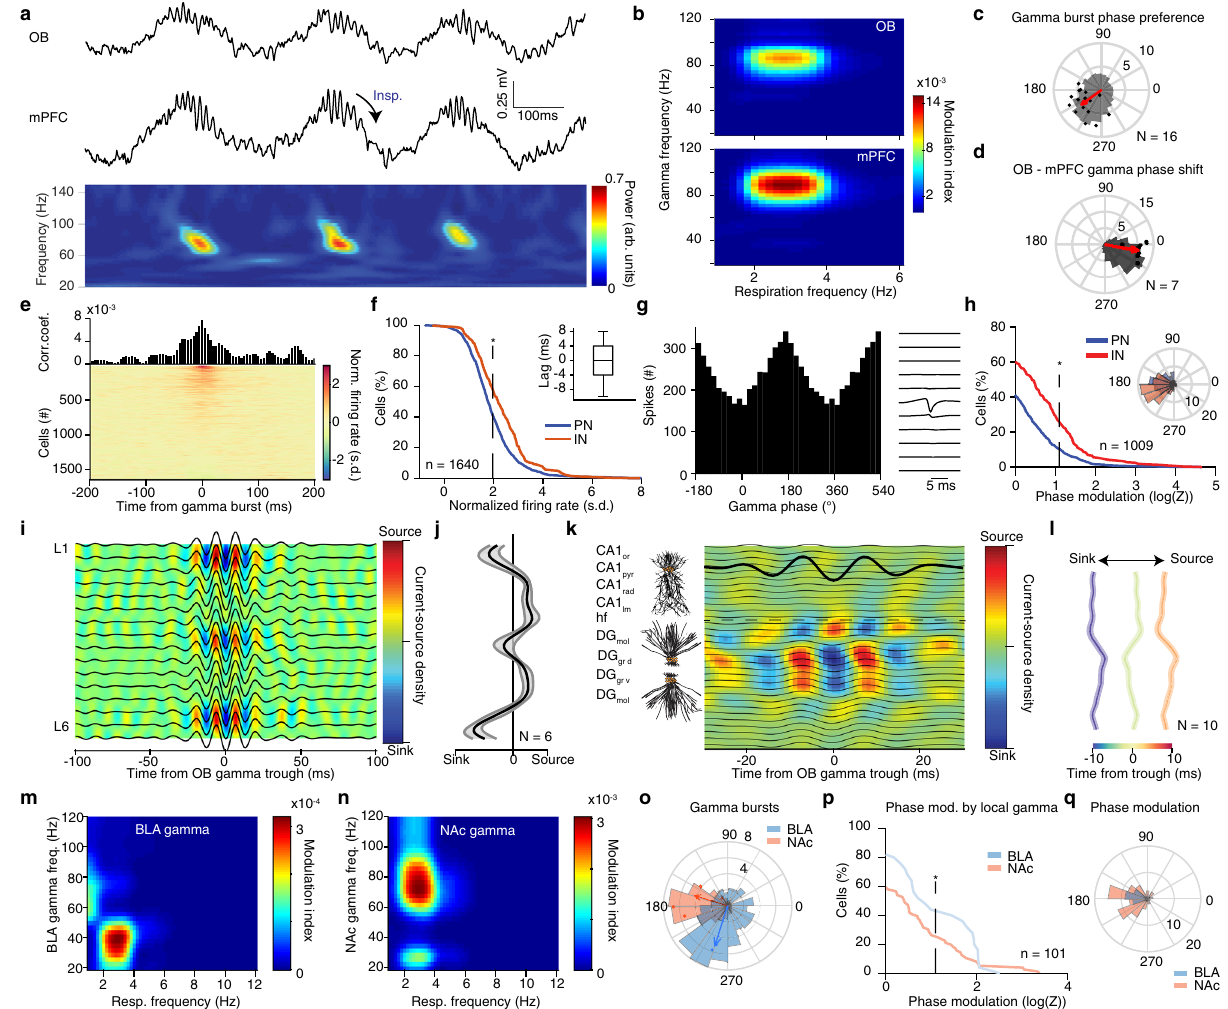
Fig. 4 Reafferent gamma entrainment of limbic circuits. a Example LFP traces from OB and mPFC LFP and spectral decomposition of mPFC LFP in the gamma range. b Example color-coded modulation strength of OB and mPFC gamma power by respiration phase. c Example respiratory phase distribution of mPFC gamma bursts (gray) and average (red arrow) preferred phase and modulation strength (logZ) ( N = 16 mice). d Example phase-shift distribution between OB and mPFC gamma fi ltered traces (gray) and average phase shift and phase-coupling strength (logZ, red dots) ( N = 7 mice). e Example and color-coded gamma burst triggered histograms for all mPFC cells ( n = 1640 cells). f Cumulative distribution of gamma-triggered fi ring of mPFC PNs ( n = 1250 cells) and INs ( n = 390 cells). Inset, time-lag between gamma burst and peak fi ring probability for all signi fi cantly responsive cells. g Gamma phase histogram and spike waveform for one example unit. h Cumulative distribution of modulation strength (logZ) by the local mPFC gamma phase for all PNs (blue, n = 685 neurons) and INs (red, n = 324 neurons). Inset, mean preferred phase distribution of all signi fi cantly modulated PN and IN cells. i , j Example ( i ) and average zero-lag ( j ) OB gamma-triggered translaminar mPFC CSD. ( N = 6 mice). k , l Example and average OB-gamma-triggered hippocampal CSD at different time-lags from OB gamma trough ( N = 10 mice). Horizontal line: fi ssure. m , n Example phase-power modulation of BLA ( m ) and NAc ( n ) gamma by respiration. o Example distribution of respiration phase for BLA and NAc gamma bursts (histogram) and mean preferred phase of gamma occurrence and modulation strength (dots; BLA, blue, N = 3 mice; NAc, red, N = 4 mice). p Cumulative distribution of modulation strength by local gamma phase of spikes for all BLA (blue, n = 25 cells) and NAc cells (red, n = 76 cells). q Distribution of the mean preferred gamma phase for each signi fi cantly modulated BLA and NAc cell. Star indicates signi fi cance (* P < 0.05). Shaded areas, mean ± SEM. For box plots, lines correspond to the median, bottom, and top quartile, and whiskers to extremes minus